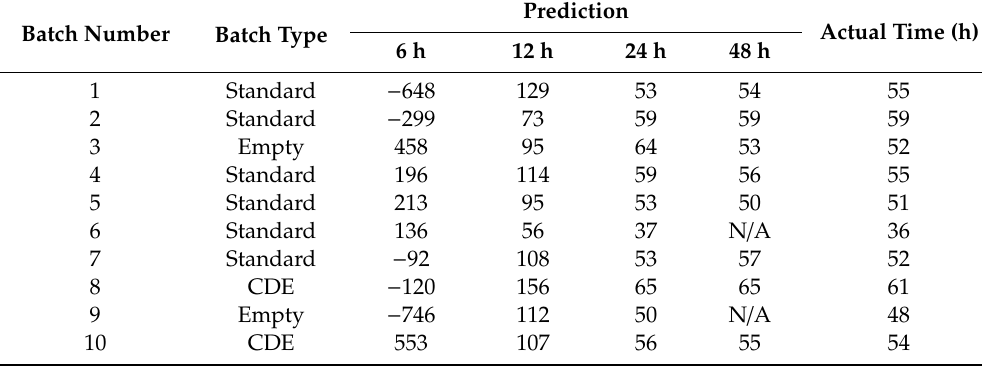
Table 1. Application of the process-to-target script to each of 10 batches monitored using the Incyte probe at several process timepoints after seeding. The numbers in the prediction columns represent the predicted infection time (in hours post-seeding). Actual time indicates the time in hours that the permittivity equaled the nominal target of 2.2 pF / cm. “N / A” indicates a timepoint that was past the point where the target was reached. For the details on batch nomenclature, the reader is referred to Figure 1. CDE = cell density e ff ect. The data presented in this table was calculated after batch completion. Batch Number Batch